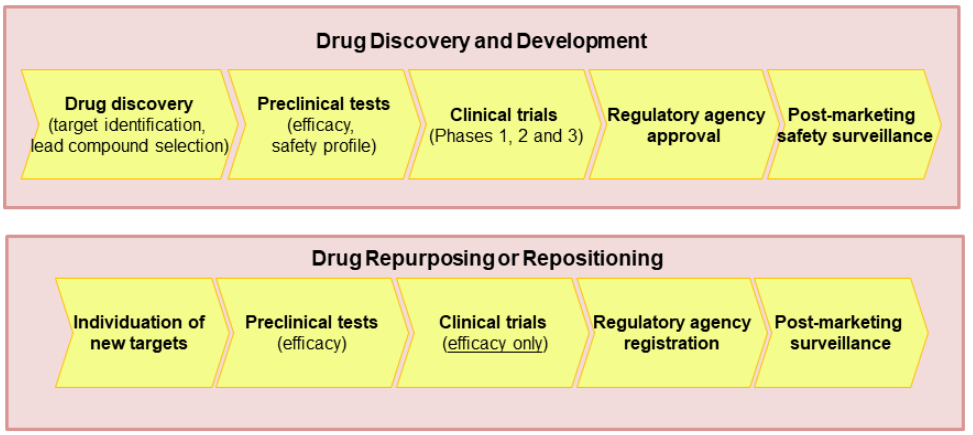
Figure 1. The main differences between drug discovery and development and drug repurposing processes.